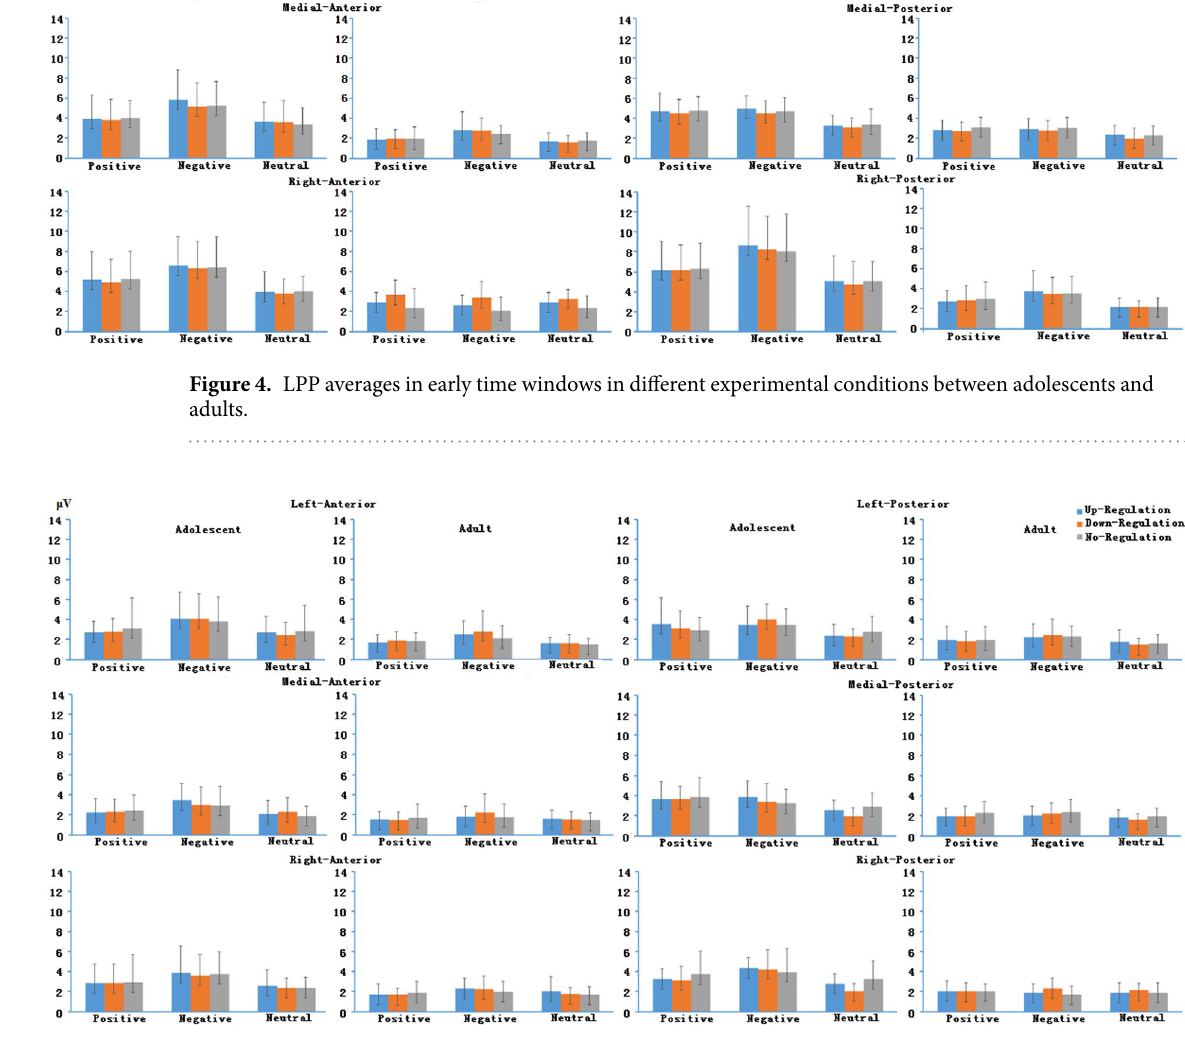
Figure 5. LPP averages in middle time windows in different experimental conditions between adolescents and